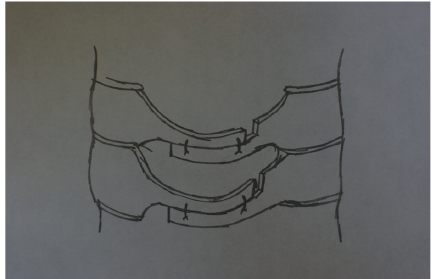
Figure 2: In the original “Z-plasty,” after troughs are drilled at the junction between the lamina and lateral mass, the laminae are thinned, a “Z” is cut in the laminae with a drill, and, as shown here, the laminae are spread apart and held with wire or suture to maintain the expanded canal